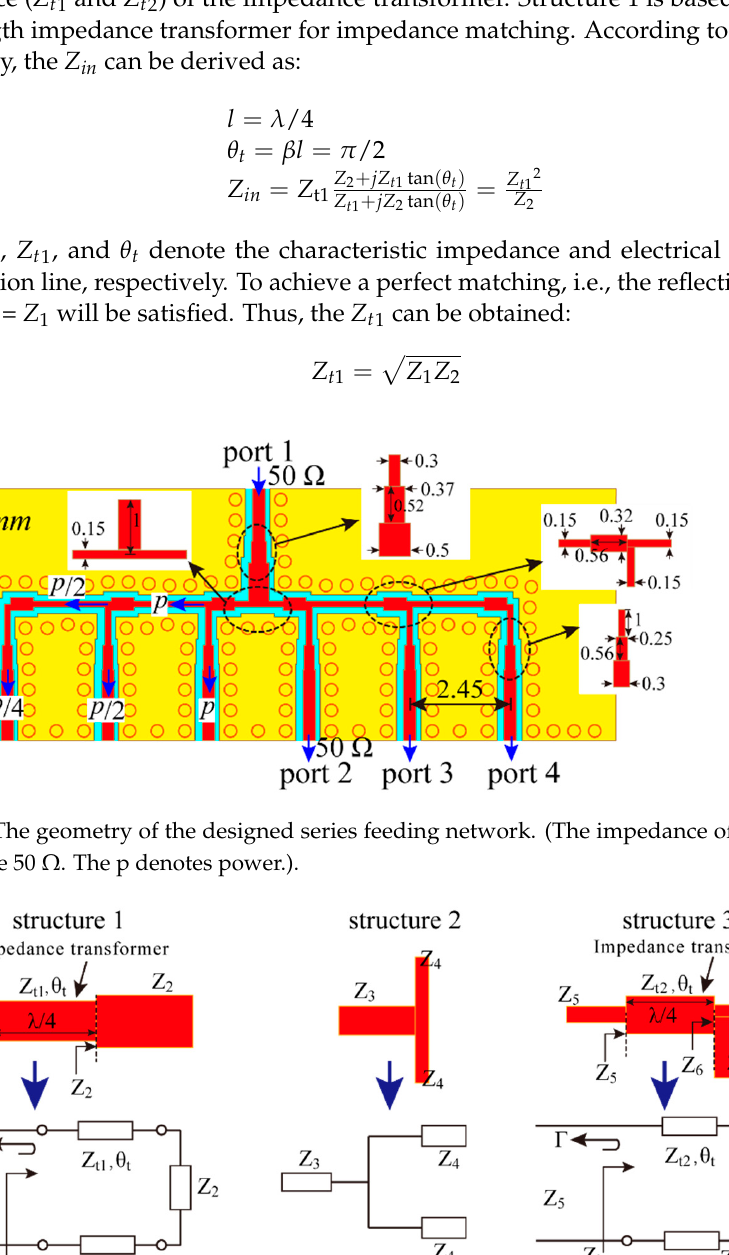
( b ) Figure 6. The simulated results of the feeding network. ( a ) S − parameters. ( b ) Output phases. 2.3. The Design and Analysis of AMC Structure As mentioned in the introduction, the microstrip-based feeding network inevitably generates undesirable radiation due to its semi-open structure. In this sub-section, the principle and design process of using AMC to suppress the undesirable radiation will be elaborated upon. A new type of high-impedance electromagnetic (EM) surface is devel- oped in [28]. The typical geometry is mushroom-like structures arranged in a two-dimen- sional lattice. In this design, we use a bed of nails formed by pins distributed in a two- dimensional lattice to achieve a high-impedance EM surface. Figure 7a shows the geome- try of the bed of nails. Since the size and periodicity of the unit cell are much smaller than the operating wavelength, a simplified lumped circuit model can be used to describe the EM properties of the bed of nails. Figure 7b shows the equivalent lumped circuit model. It can be seen as a parallel resonant circuit, consisting of capacitance and inductance. The surface impedance can be expressed as: